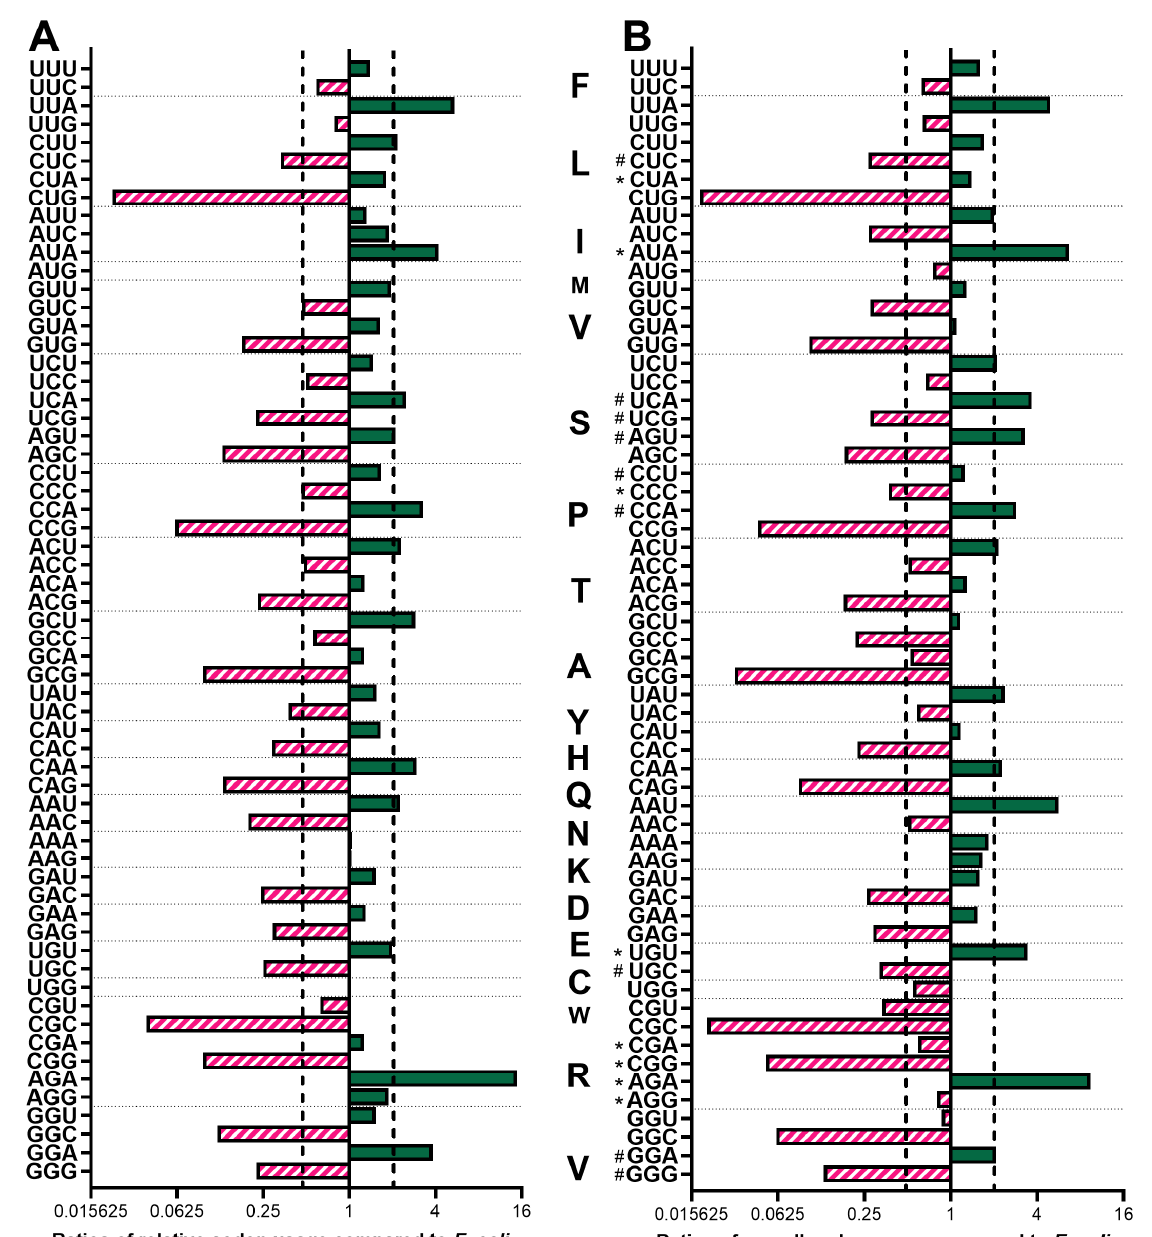
Figure 2. Relative and overall codon usage of P. indianae compared to E. coli . ( A ) Ratios of P. indianae ’s codon usage relative to codons for the same amino acids compared to E. coli . ( B ) Ratios of P. indianae ’s overall codon usage relative to all codons compared to E. coli . Ratios below 1 are shown in pink to indicate codons used more frequently in E. coli than P. indianae ; ratios above 1 are shown in green to indicate codons used more frequently by P. indianae than E. coli . The vertical black dashed lines mark the 2-fold increase or decrease in codon use compared to E. coli . * and # indicate E. coli codons that are rare ( ≤ 0.5% overall usage) and semi-rare ( ≤ 1.0% overall usage), respectively. Delineations between codons encoding different amino acids are indicated by horizontal dashed gray lines.